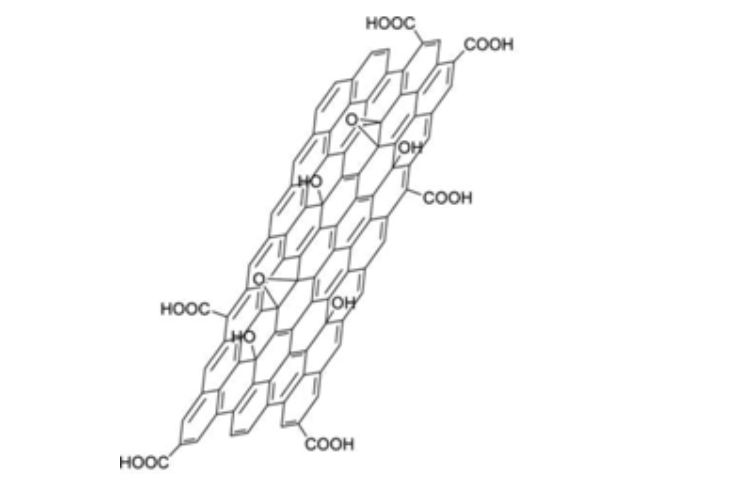
Figure 1. Graphene oxide structure representation. Reprinted with copyright permission from reference [15]. Copyright © 2012, American Chemical